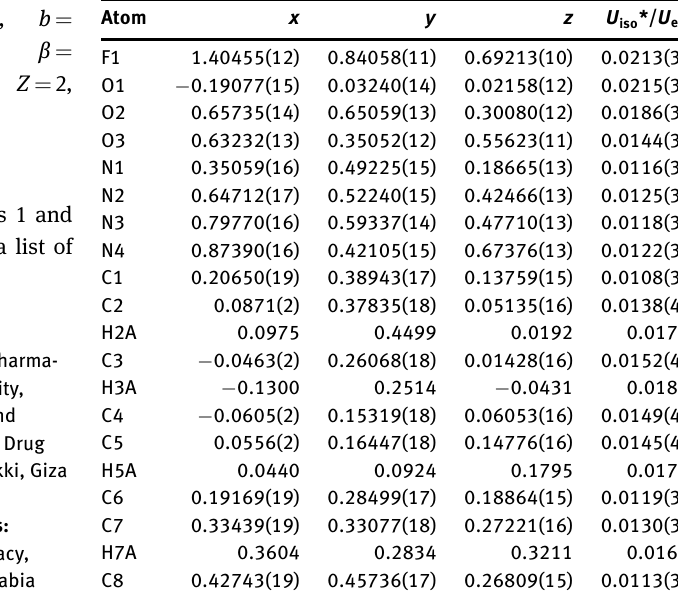
Table 2: Fractional atomic coordinates and isotropic or equivalent isotropic displacement parameters (Å 2